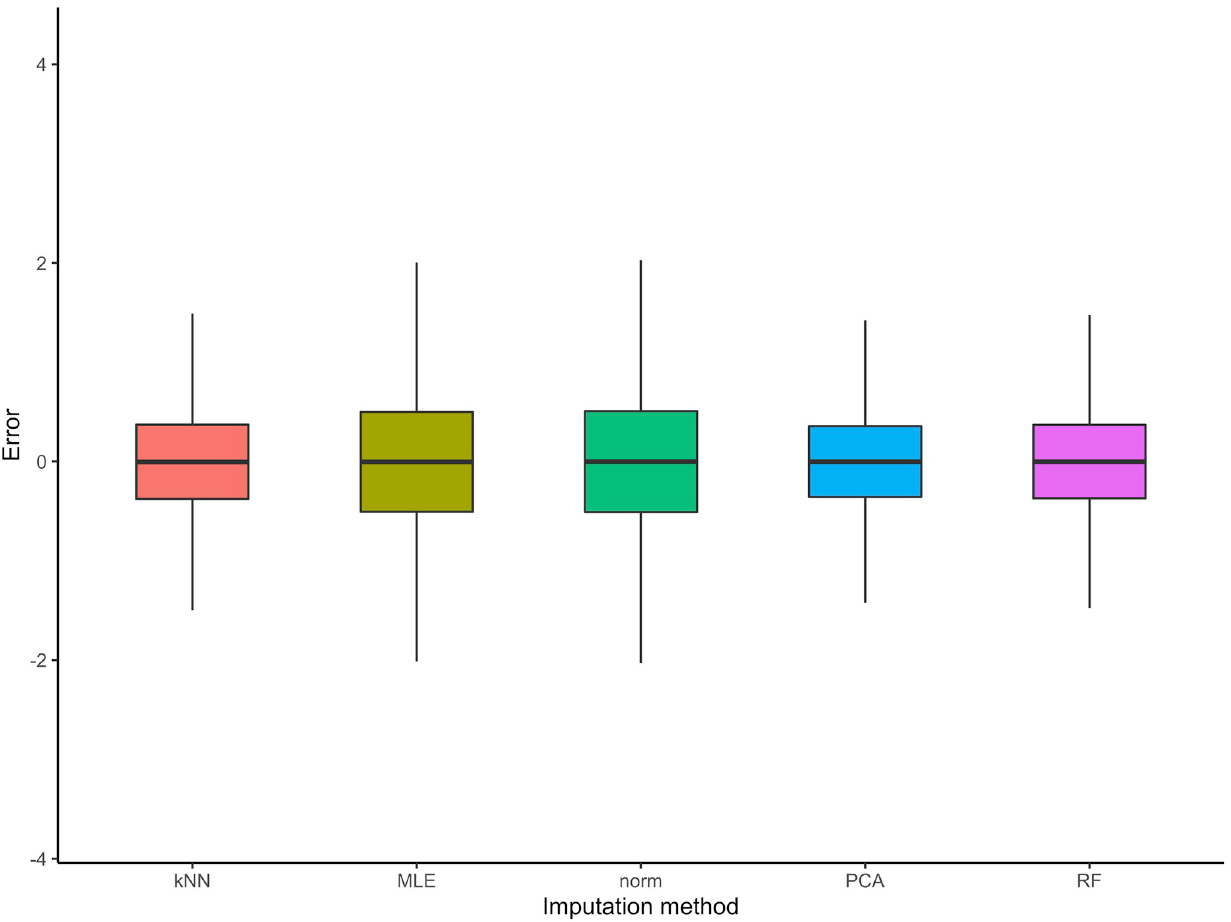
Fig 4. Distribution of empirical errors for the five imputation methods considered on the second set of MAR simulations.